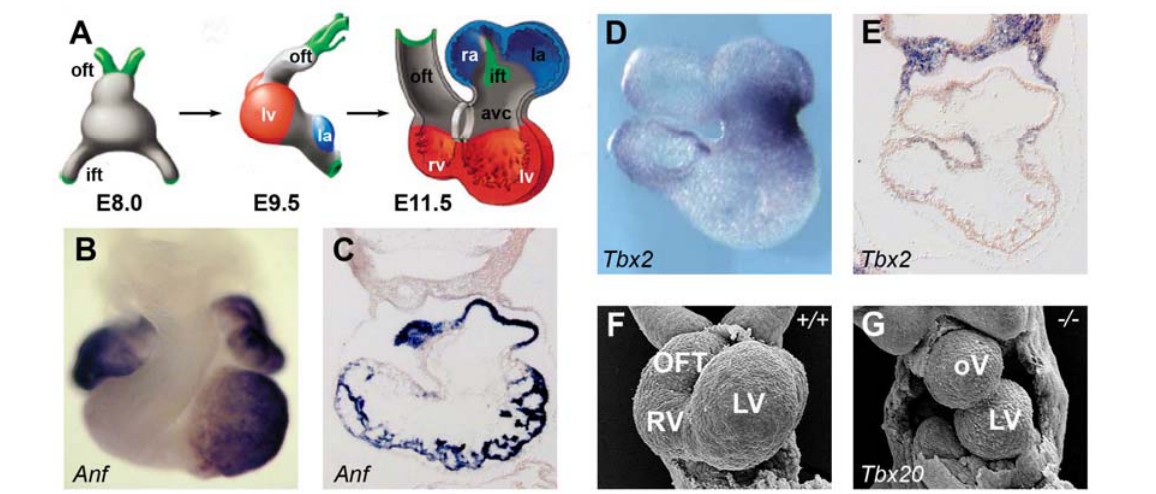
FIGURE 3. The “ballooning” model for cardiac chamber expansion. (A) Illustrations of the embryonic mouse heart at E8.0, E9.5, and E11.5 showing primary (nonchamber) myocardium (grey), ventricular chamber myocardium (red), atrial chamber myocardium (blue), and the inflow and outflow tracts (green). Chamber myocardium “balloons” out from the outer curvature of the looped heart tube to generate the atria and ventricles, the inner curvature remains primary, nonchamber myocardium and contributes to the inflow tract, outflow tract, and AVC. (B–E) In situ hybridization analysis of whole mount hearts (B,D) and sections (C,E) highlights the mutually exclusive expression patterns of Nppa (encoding atrial natriuretic factor; B,C), which marks the cardiac chambers (albeit weakly in the right ventricle), and Tbx2 (D,E), which marks the nonchamber regions of the heart and represses the formation of chamber myocardium. (F,G) Scanning electron micrographs showing hearts from wildtype (F) and Tbx20 -/- (G) embryos at E9.0. Tbx20 is required for the differentiation of chamber myocardium. Tbx20 -/- embryos develop small, abnormal ventricle-like chambers in which chamber myocardium does not differentiate, most likely due to up- regulation of Tbx2 . LA, left atrium; LV, left ventricle; RA, right atrium; RV, right ventricle; OFT, outflow tract; IFT, inflow tract; AVC, atrioventricular canal; oV, outflow ventricle-like chamber. A is modified from Christoffels et al.[111], ©2004 with permission from Elsevier; B, C, and E are reproduced from Habets et al.[39], ©2002 with permission from Cold Spring Harbor Laboratory Press; D is reproduced from Harrelson et al.[45], ©2004; and F and G from Stennard et al.[41], ©2005 with permission from the Company of Biologists